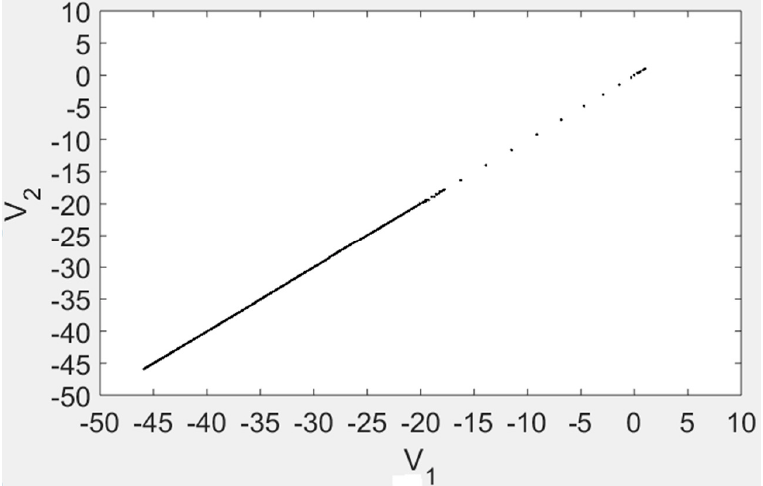
Figure 6. Locus (V 1 , V 2 ) when H syn = 1.55 and τ = 0.